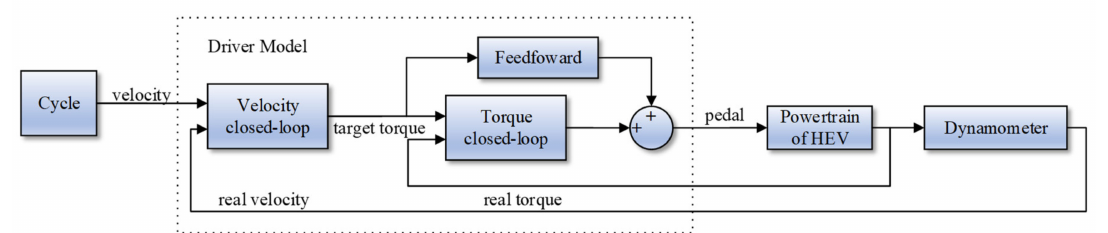
Figure 7. The emulation algorithm of the driver model.